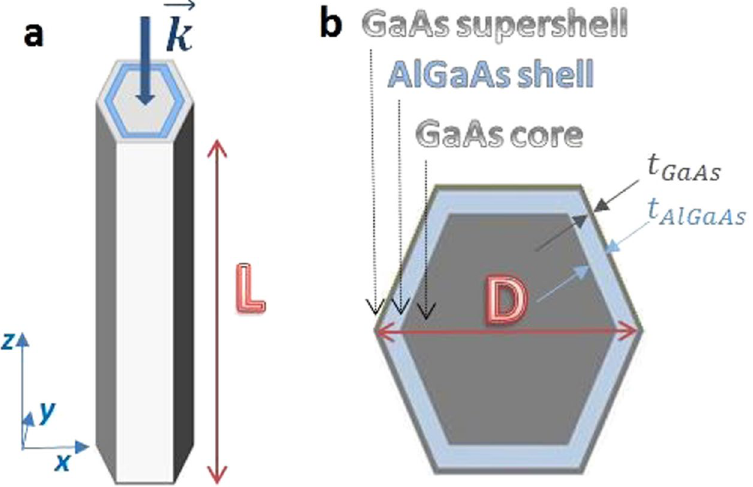
 k is always parallel to L and normally